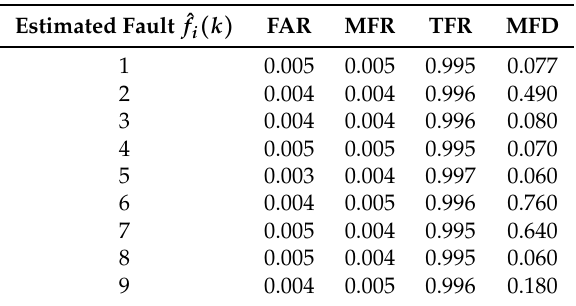
Table 9. Performance indices with fuzzy fault estimators. MFR, Missed Fault Rate; TFR, True FDI Rate; MFD, Mean FDI Delay.